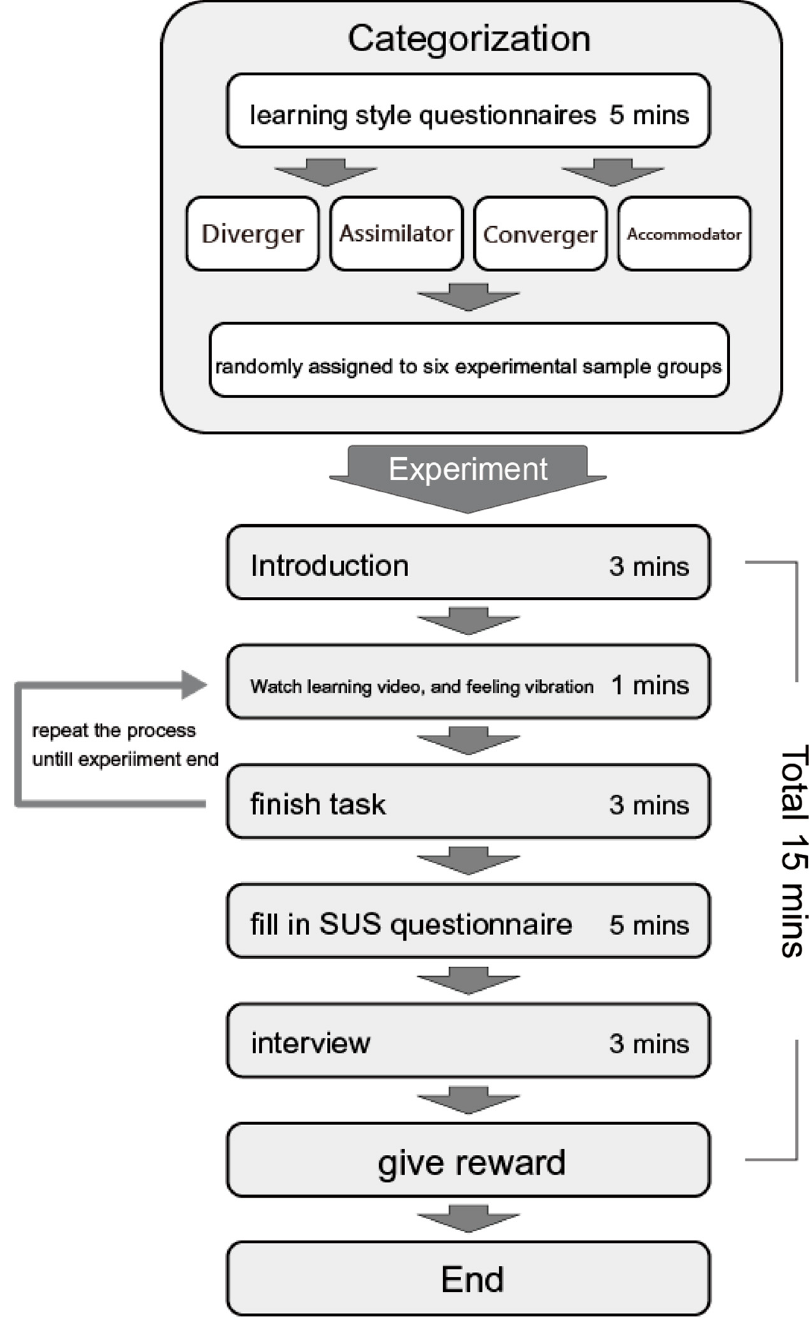
Figure 8. Experiment process.